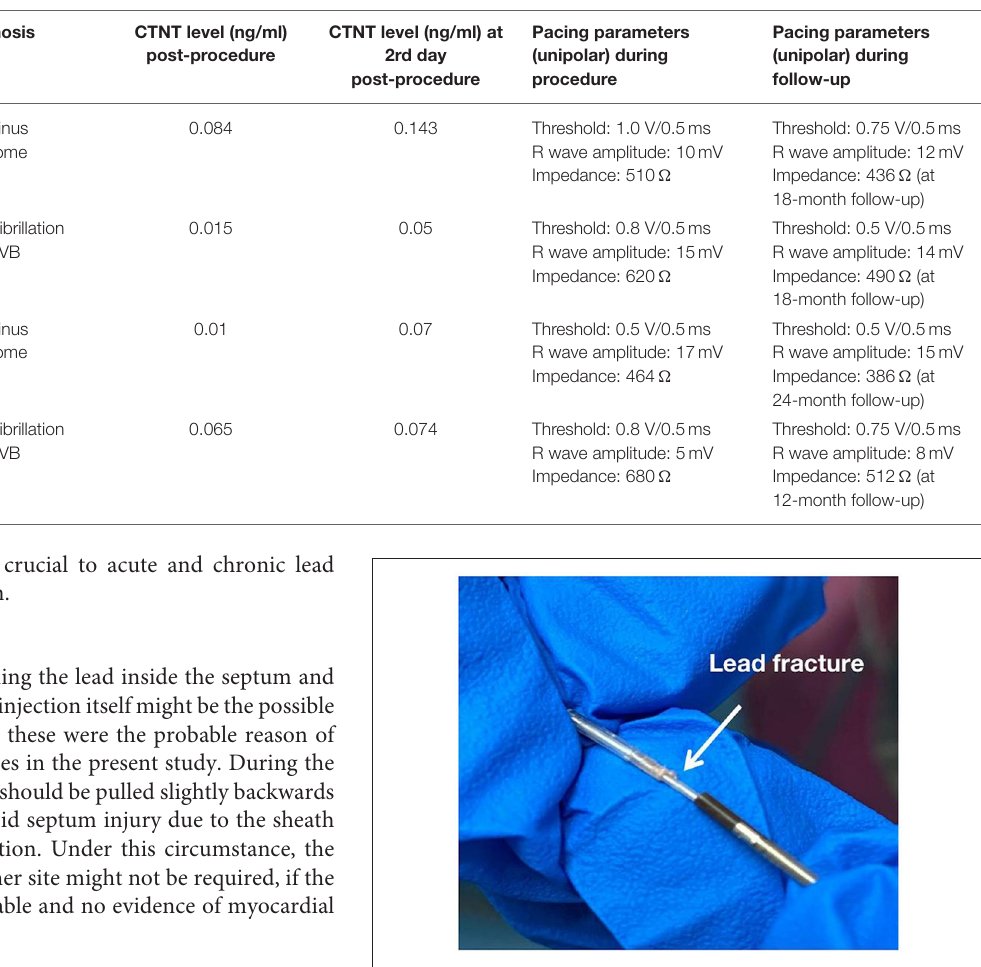
FIGURE 6 | Image of lead fracture between the lead body and the end of the